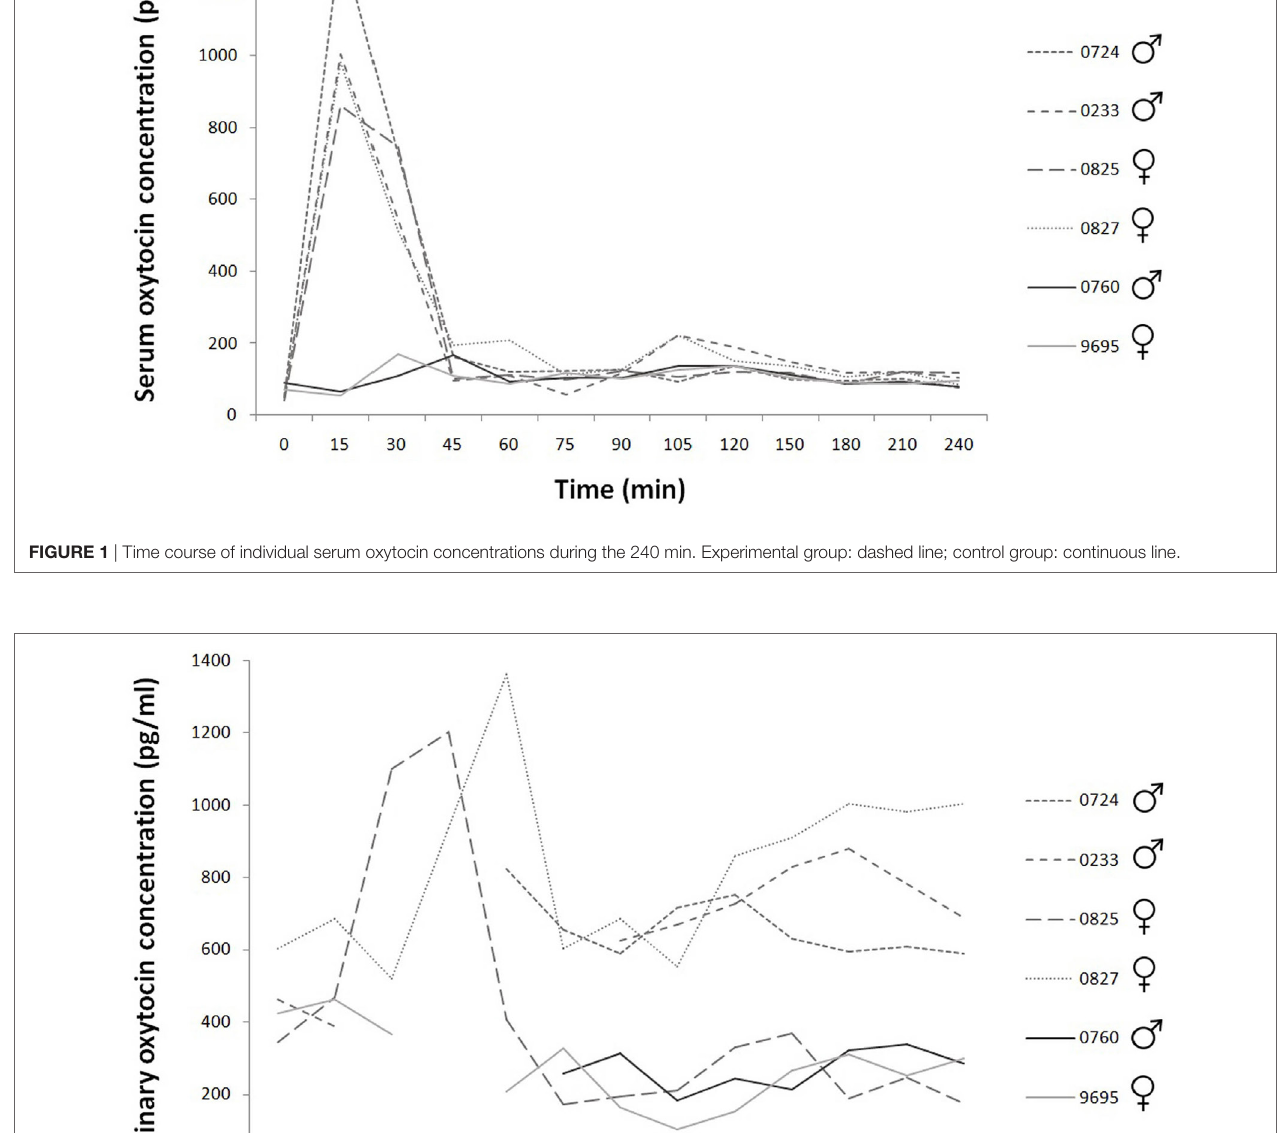
male dogs there are missing data points (urinary cortisol: 78 cortisol/creatinine ratio (c/c ratio)